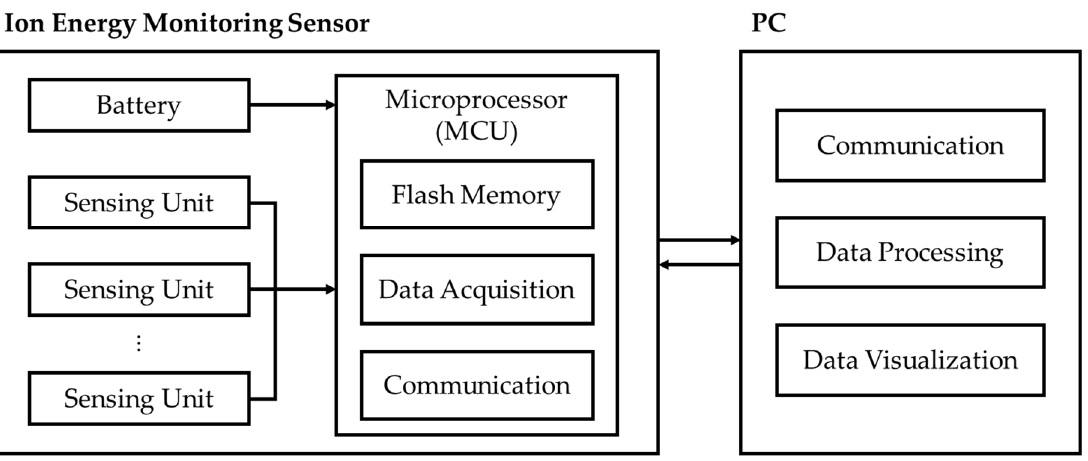
Figure 2. Block diagram of IEMS.